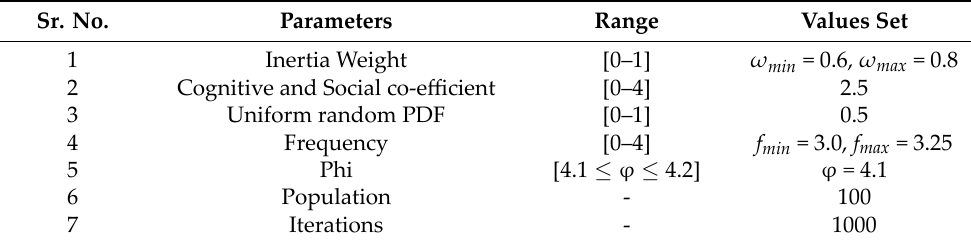
Table 1. Parameters of HPSOBA, MHPSO-BAACs used for simulation. Sr. No.